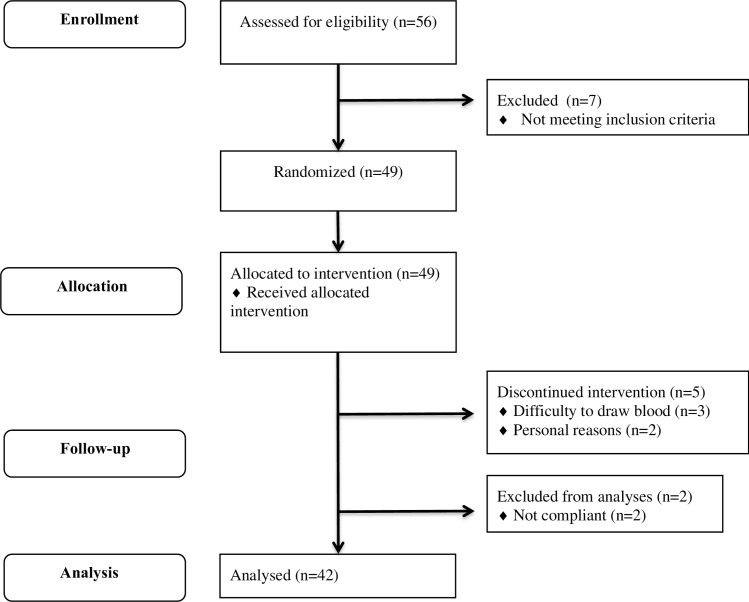
Subject flow chart.